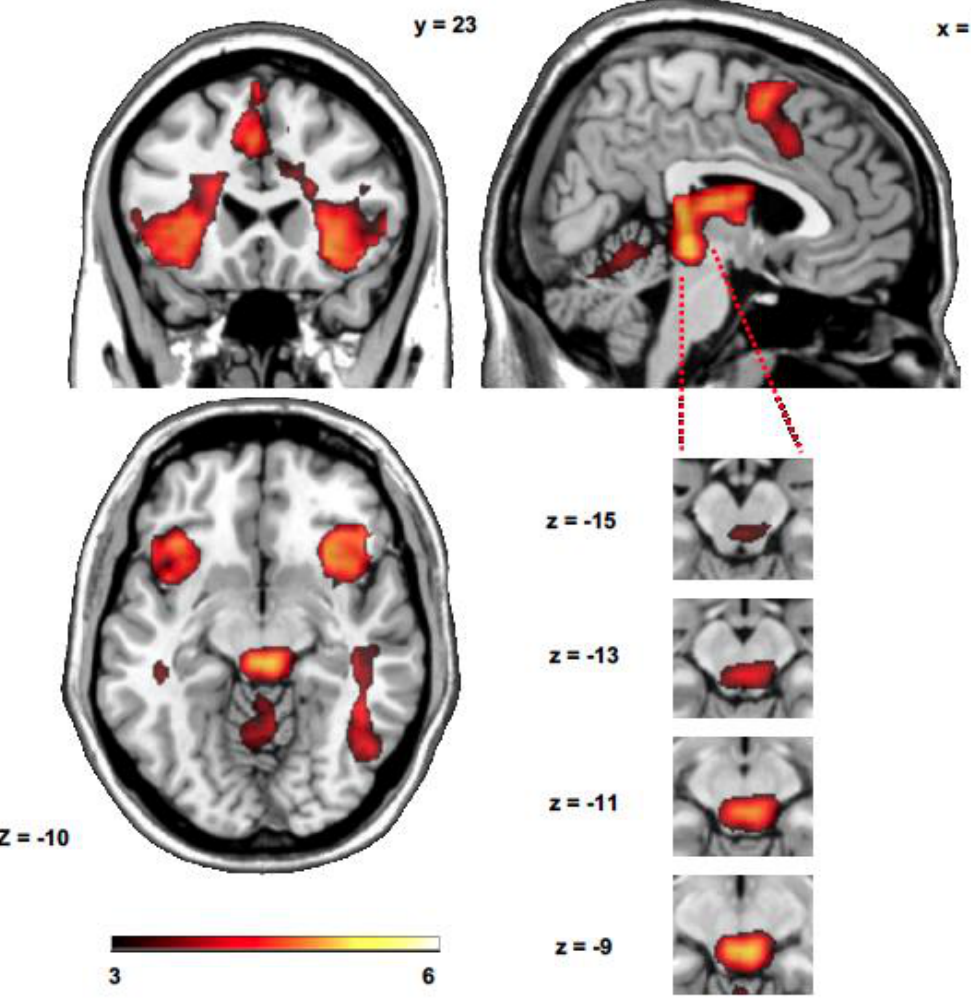
Figure 2. SPM maps showing the whole brain and specific midbrain activity during up emotion regulation with respect to down emotion regulation . Activation maps are superimposed on a Ch2 template using the MRIcron software (version 2016) [66]. Table 1. BOLD activations during all real-time fMRI-based emotion regulation runs. The statistical threshold was set at p < 0.001 cluster level corrected using probabilistic threshold-free cluster enhancement (pTFCE).